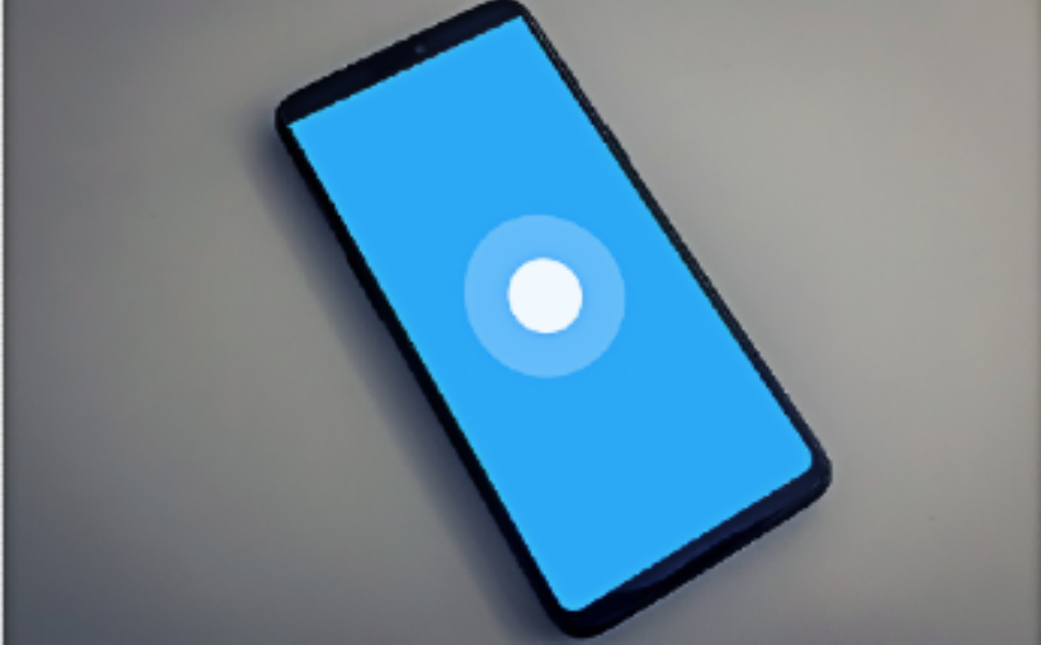
Figure 5. Visualization of the standard breathing training Circle. It served as a comparison for the impact of Breeze on participants' HRV measures. This way, the authors were able to ensure that Breeze yields similar physiological results although it employs game